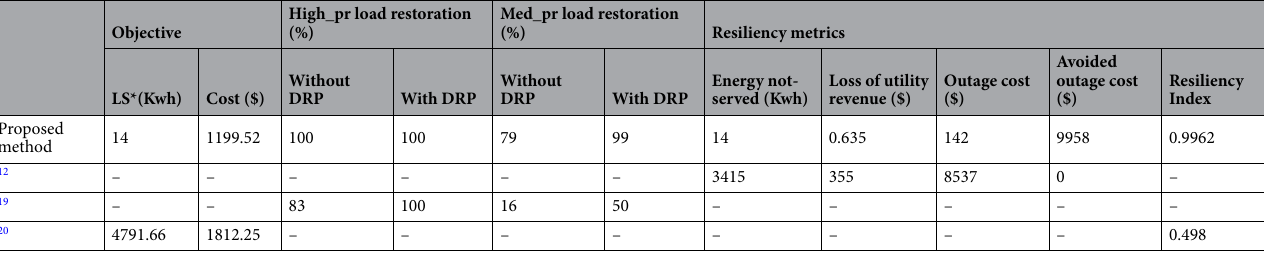
Table 5. Comparison between different microgrid formation strategies for enhancing DN Resiliency. LS * : Load Shedding, High_pr load restoration: the total amount of high priority loads that are served when applying the proposed method, Med_pr load restoration: the total amount of medium priority loads that are served when applying the proposed